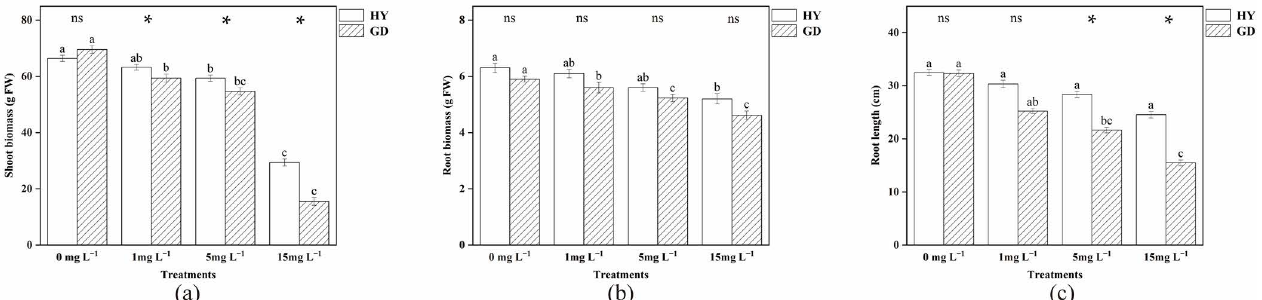
Figure 1. Shoot biomass ( a ), root biomass ( b ), and root length ( c ) of two Chinese flowering cabbages under different doses of As by ANOVA test. * indicates significant ( p < 0.05) differences between two cultivars at the same As treatment by t -test. Different letters indicate significant ( p < 0.05) differences among different As treatments in the same cultivar, the same below. Table 1. As speciation in two Chinese flowering cabbages under different doses of